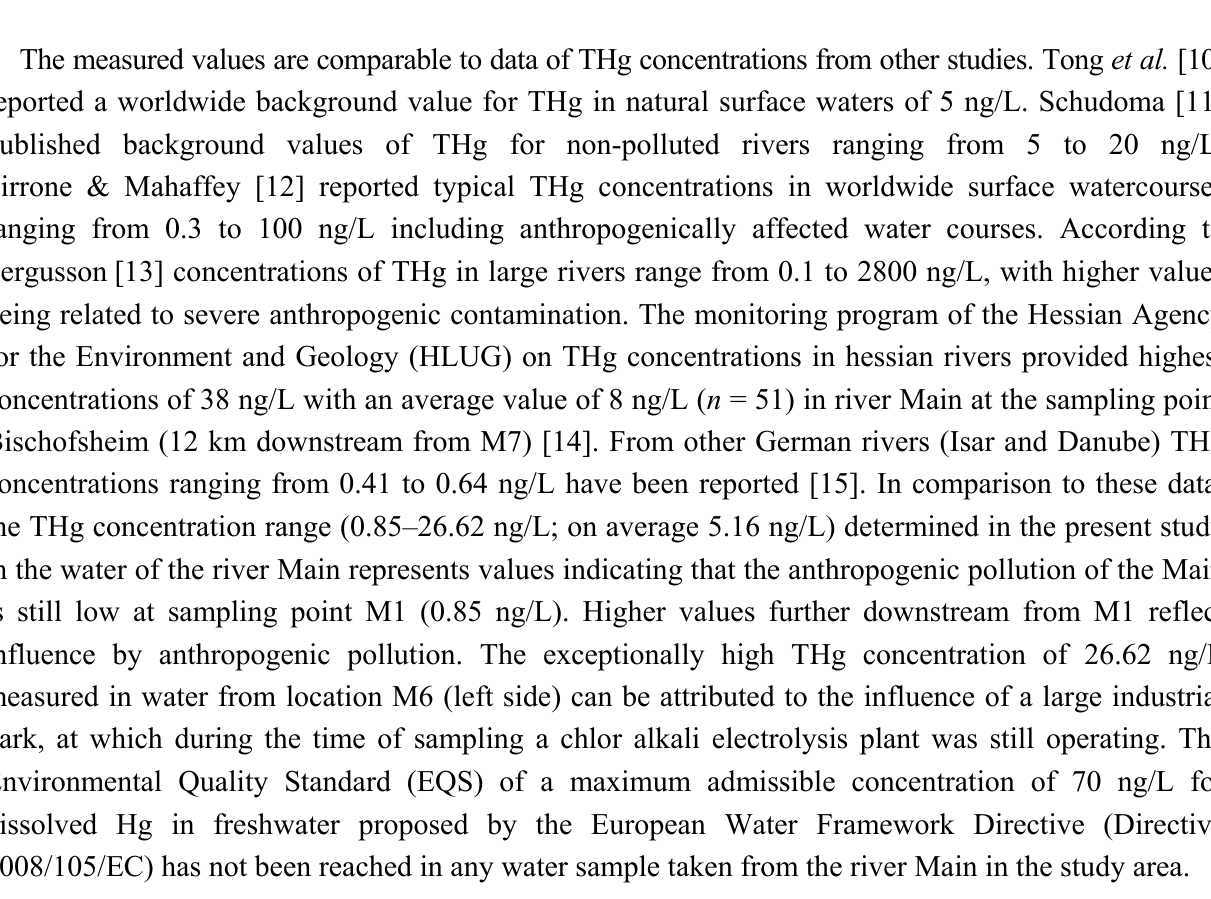
Figure 3. Results from the determination of THg concentrations at 7 sampling points of river Main (M1–M7) at the right and left side on ( a ) 22 October 2014; ( b ) 02 December 2014 and ( c ) the calculated mean THg loads from both sampling campaigns and both sites of the